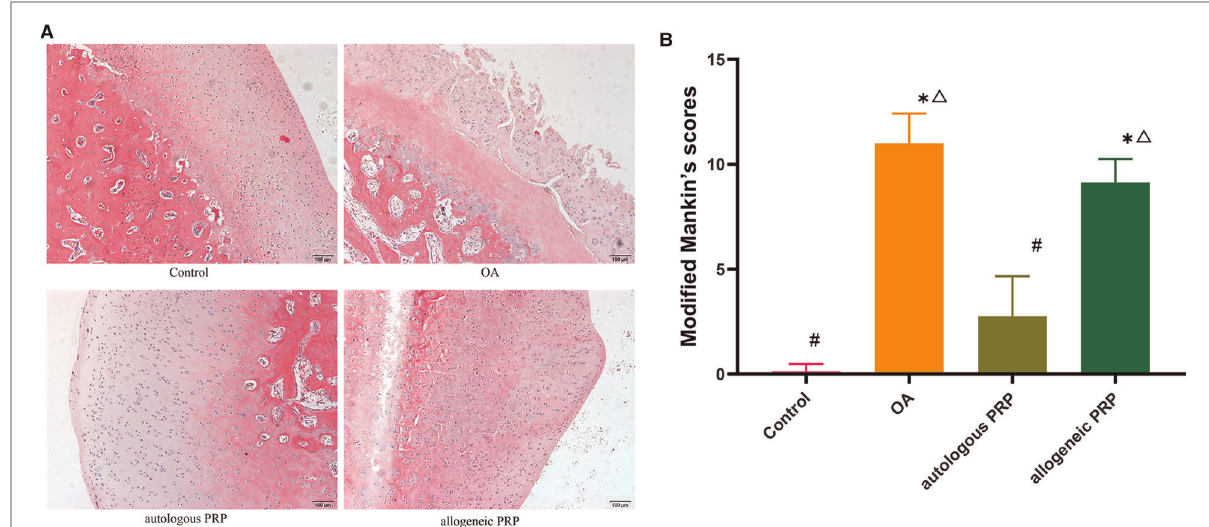
FIGURE 1 Histological images and analysis of articular facet(femur) cartilage. ( A ) H&Estained sections of articular artilage. Scale bar 100 μ m. ( B ) Cartilage destruction was assessed using the Mankin scoring system. All groups ( n =8). Groups were expressed as * p <0.01 if signi fi cantly different compared control, # p <0.05 compared to OA, and ? P <0.05 compared to autologous PRP. H&E, hematoxylin and eosin; OA, osteoarthritis; PRP, platelet-rich plasma.